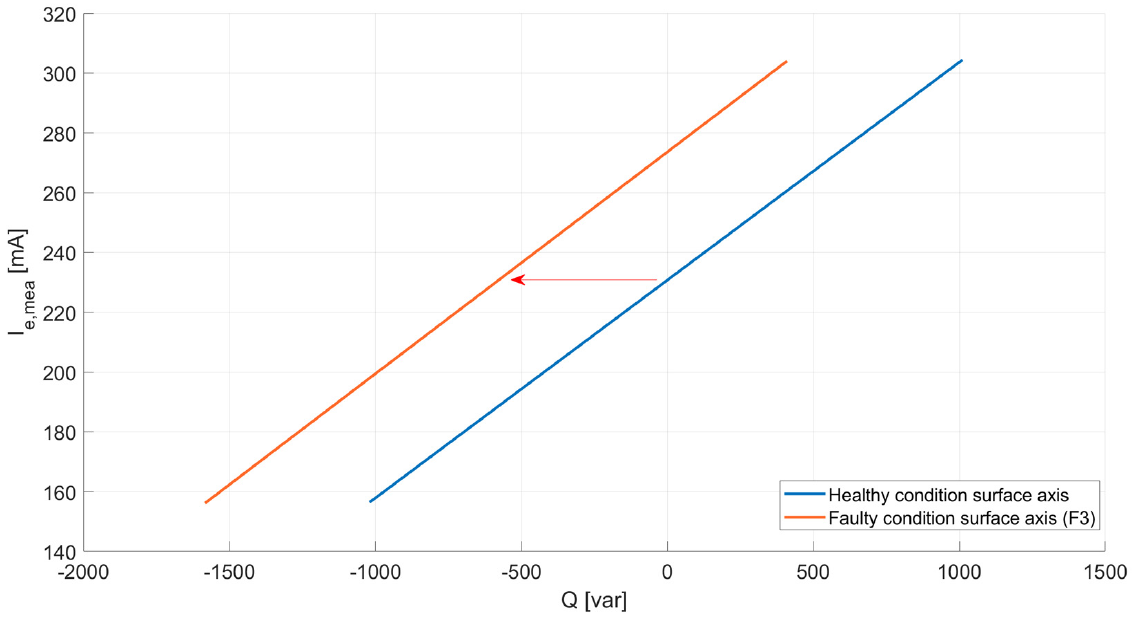
Figure 17. Experimental results. Representation of I e,mea healthy and faulty conditions (F3: open- phase fault), surface axis for P = 1500 W at U = 400 V.